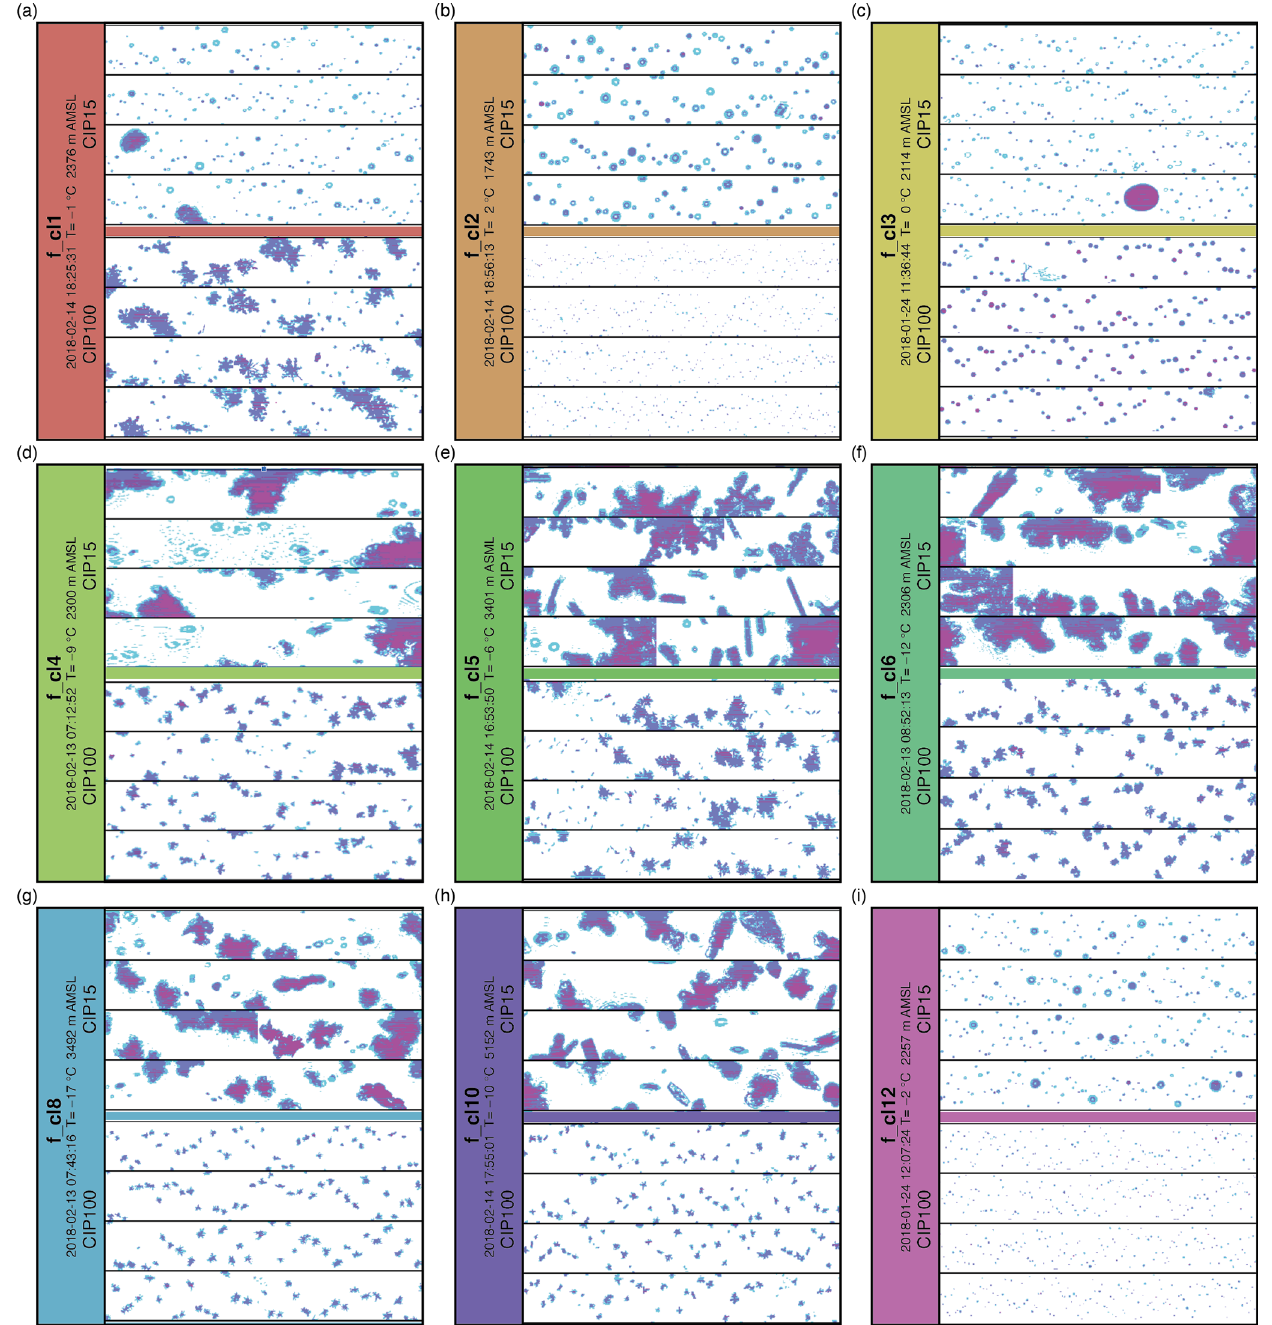
Figure 9. Examples of the images taken from the cloud image probe CIP-15 (15µm, upper) and CIP-100 (100µm, lower) within a 30km range of the radar position: (a) for f_cl1 – at 18:25:31UTC on 14 February 2018; (b) for f_cl2 – at 18:56:13UTC on 14 February 2018; (c) f_cl3 – at 11:36:44UTC on 24 January 2018; (d) f_cl4 – at 18:17:53UTC on 14 February 2018; (e) f_cl5 – at 16:53:50UTC on 14 Febru-